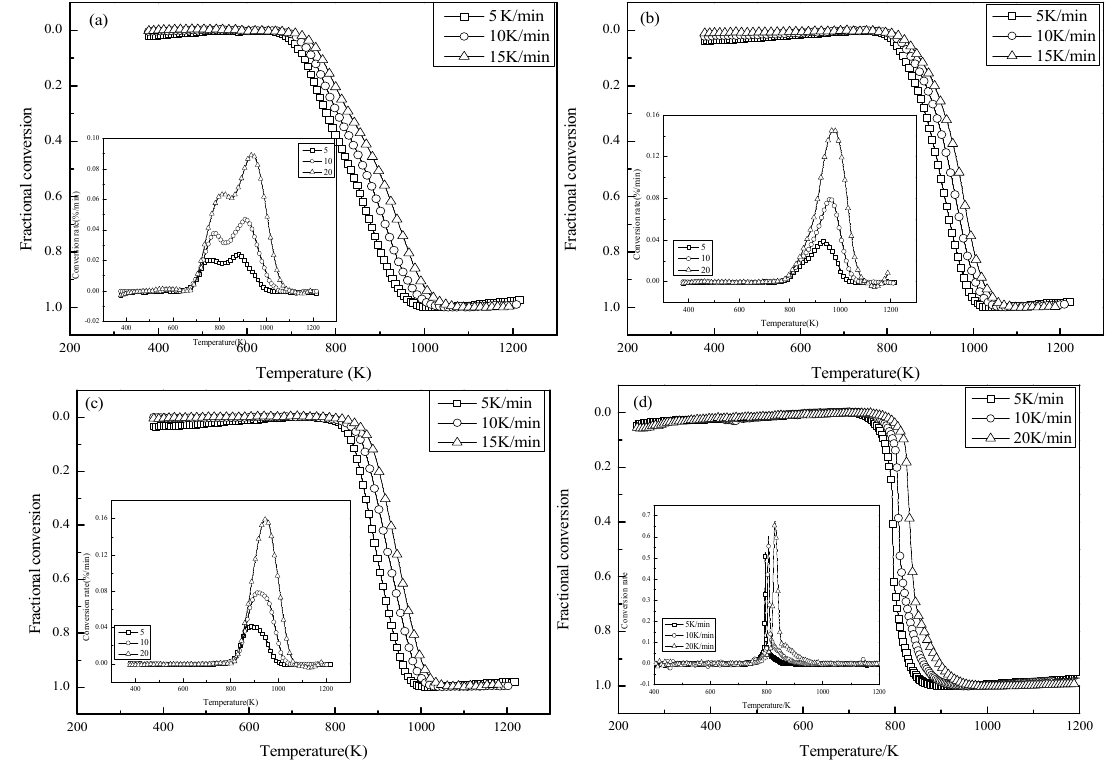
Figure 5. Fractional conversion curves and conversion rate curves of samples: ( a ) RD; ( b ) C-1; ( c ) C-2; and ( d ) CC.